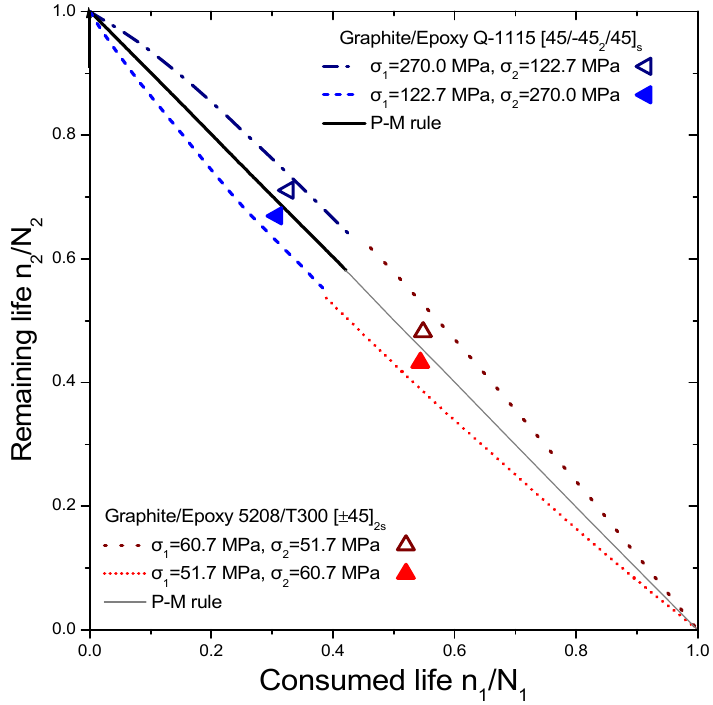
Figure 6. Analytical prediction of remaining life versus consumed life for the case of graphite epoxy (T300/5208) and graphite epoxy (G-1115). The experimental data points are taken from Ref [49,50].